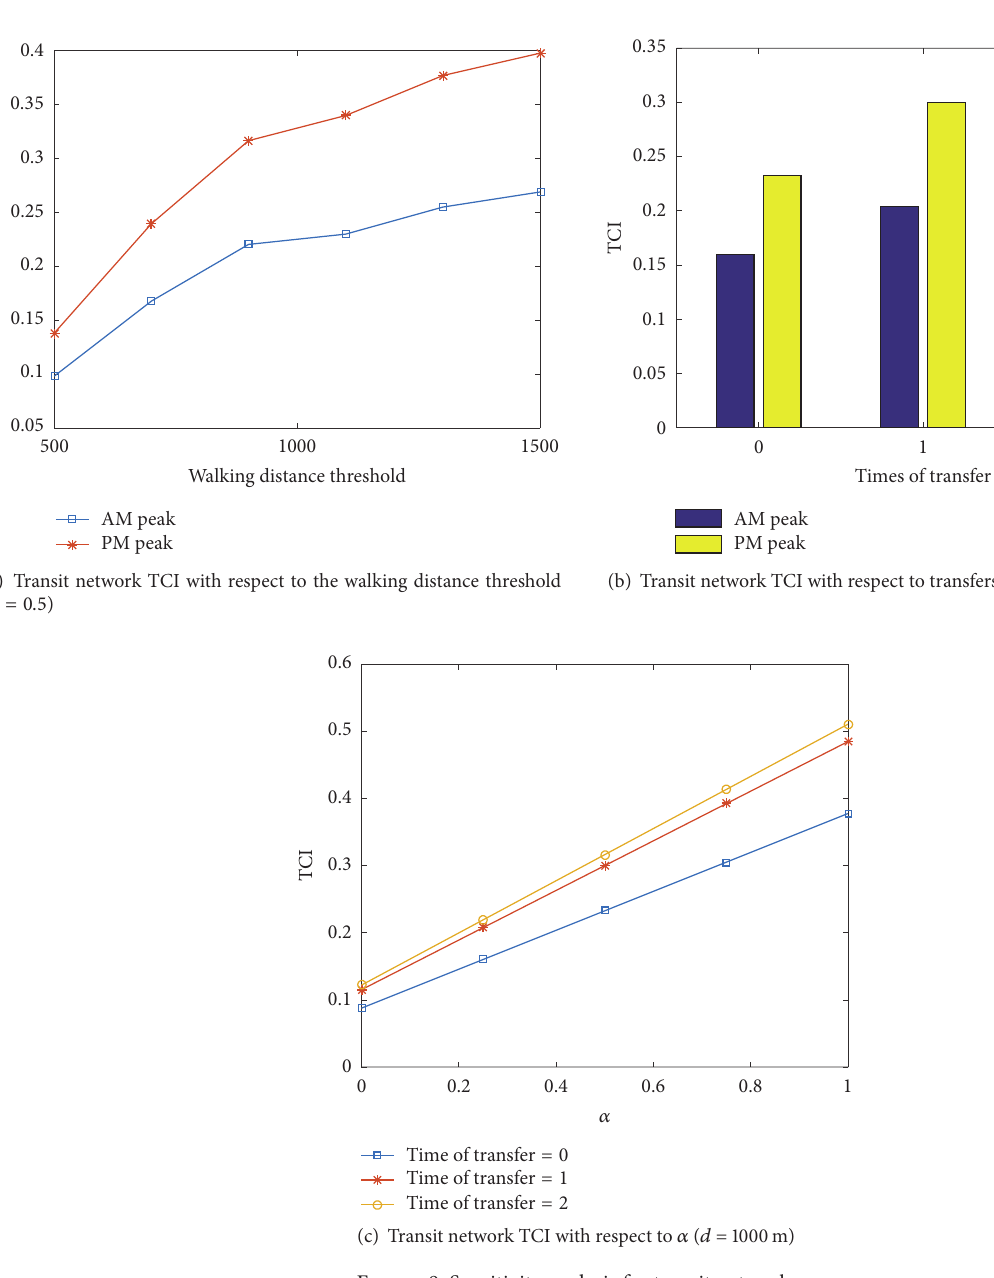
Figure 9: Sensitivity analysis for transit